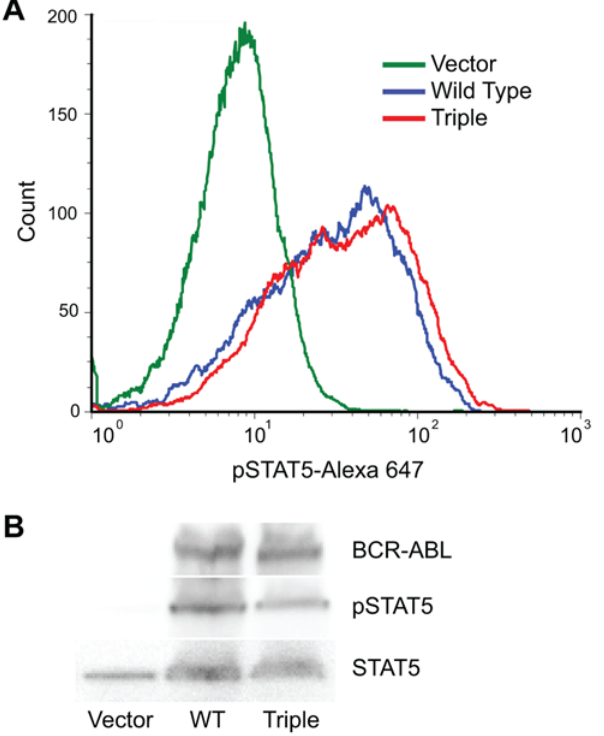
Figure 6. Analysis of phospho-STAT5 in primary cells. GFP positive primary bone marrow transduced with retroviral supernatants from wild type, triple mutant BCR-ABL or vector only was analyzed for the levels of STAT5 phosphorylation by (A) FACS analysis of cells gated for GFP positivity and stained with phospho-STAT5-Alexa 647 antibody or by (B) Western analysis with the indicated antibodies.